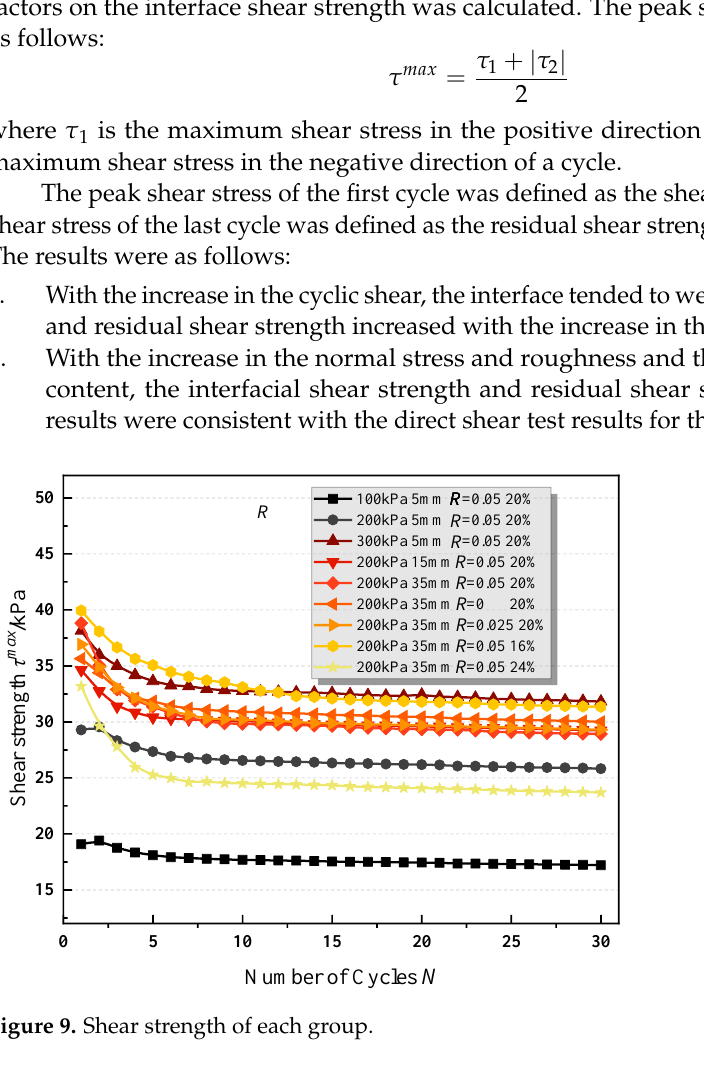
Figure 8. Shear stress-shear displacement curves with different levels of water content: ( a ) 16%; ( b ) 20%; ( c ) 24%.